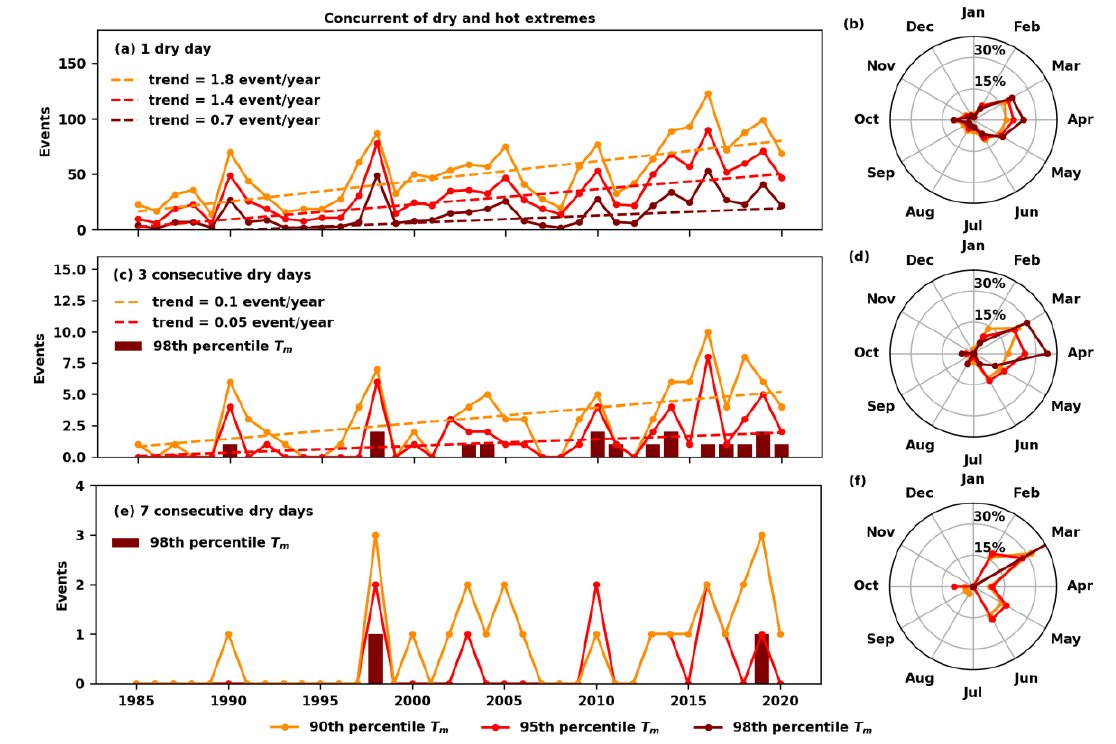
Figure 7. Inter- (number of events per year) (a,c,e) and intra-annual (number of events in the month relative to total) (b,d,f) variability of concurrent dry and hot extremes under different combinations of consecutive dry days and percentile-based daily maximum air temperature thresholds.